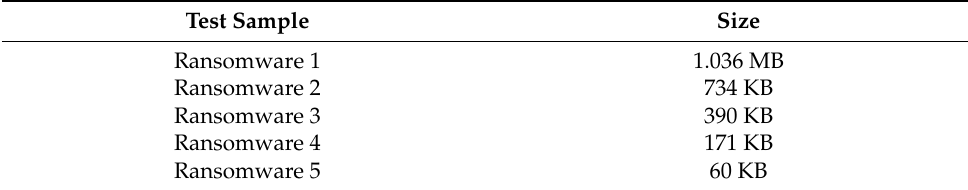
Table 2. Size of the tested ransomware